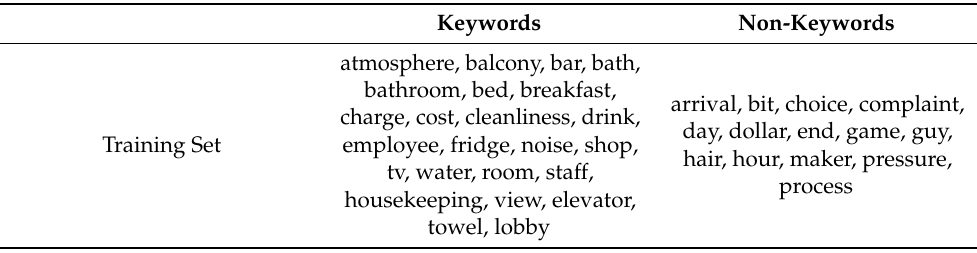
Table 3. Keywords and non-keywords in the training